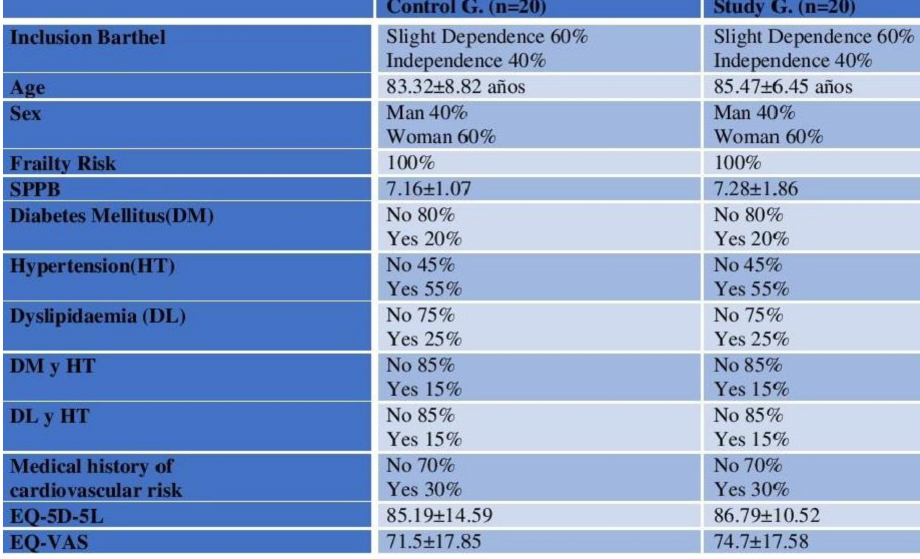
Figure 4. Description of sample features. DM: Diabetes Mellitus; HT: Hypertension; DL: Dyslipidaemia; EQ 5D-5L y